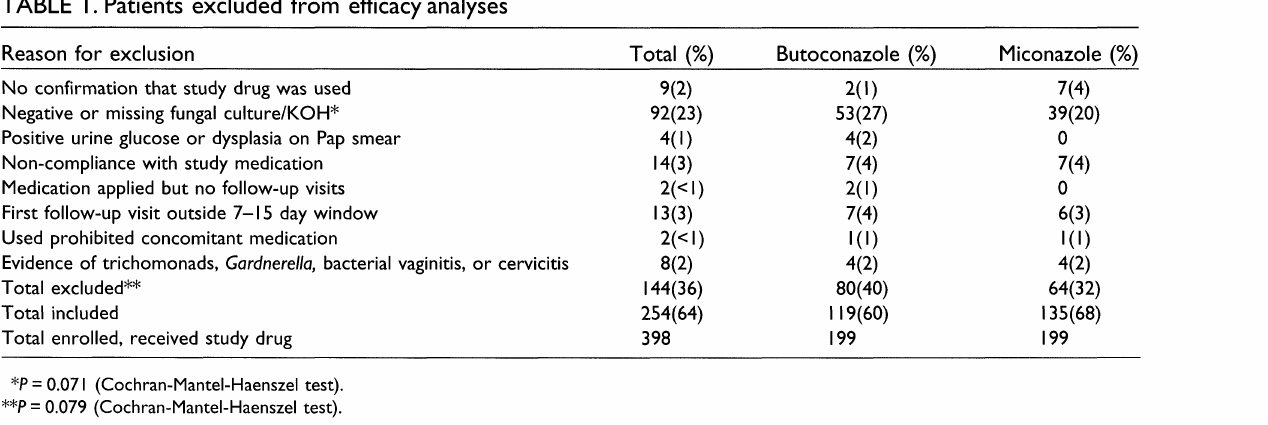
TABLE I. Patients excluded from efficacy analyses Reason for exclusion Total (%) Butoconazole (%) Miconazole (%) No confirmation that study drug was used Negative or missing fungal culture/KOH* Positive urine glucose or dysplasia on Pap smear Non-compliance with study medication Medication applied but no follow-up visits First follow-up visit outside 7-15 day window Used prohibited concomitant medication Evidence of trichomonads, Gardnerella, bacterial vaginitis, or cervicitis Total excluded** Total included Total enrolled, received study